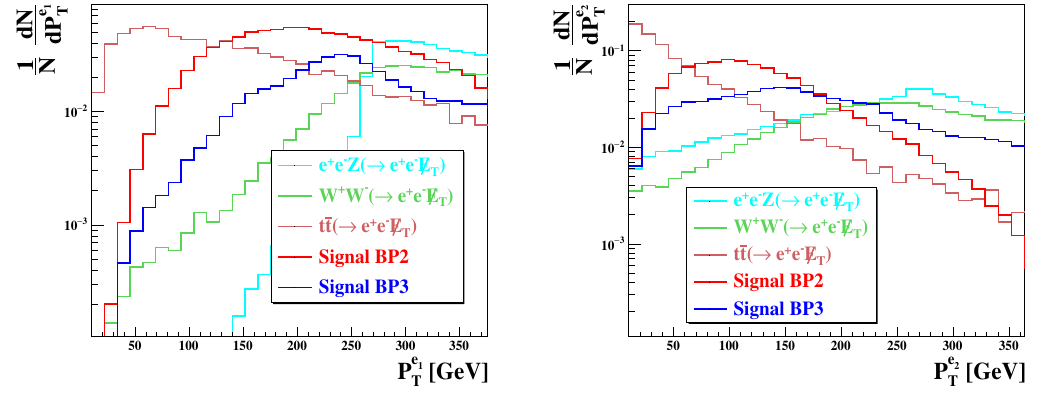
Figure 13 . Left panel shows the variation of fraction of events distribution for backgrounds and signal with the transverse momentum of leading electron whereas the right panel shows the variation with respect to the rapidity of the leading